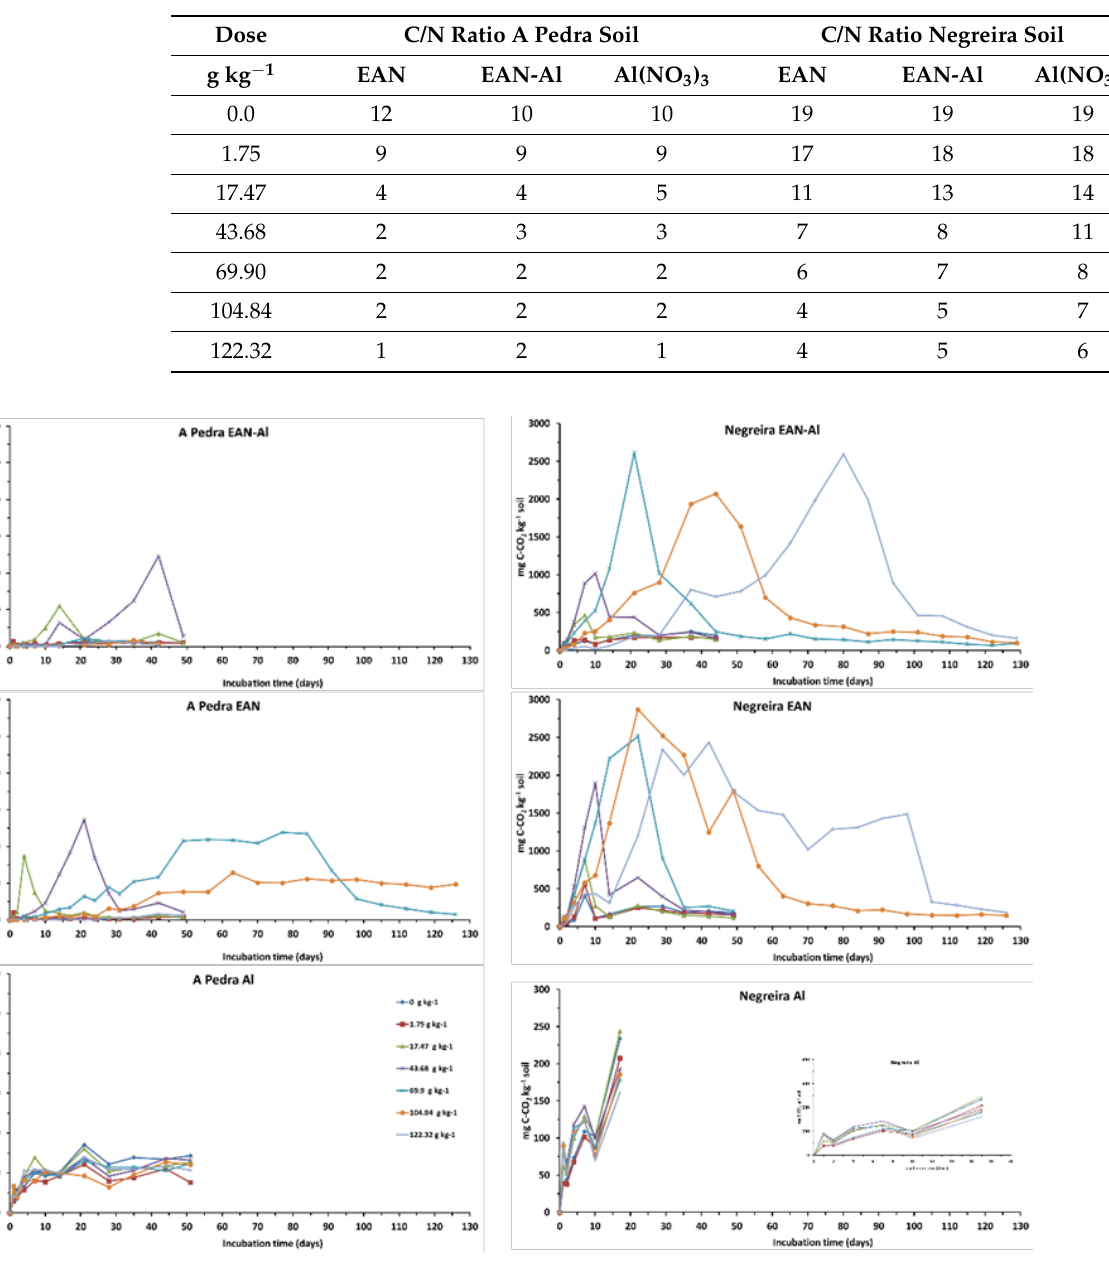
Figure 1. Kinetics of basal respiration in the unspiked A Pedra ( left ) and Negreira ( right ) soils and in the same soils spiked with different doses of the saturated mixture of ethylammonium nitrate and aluminium nitrate (EAN-Al) ( upper graphs ), ethylammonium nitrate (EAN) ( middle ), or aluminium nitrate (Al(NO 3 ) 3 ) ( lower graphs ). Note that the limits of the Y axis in A Pedra and Negreira soils spiked with the aluminium salt were lower than in the other cases.